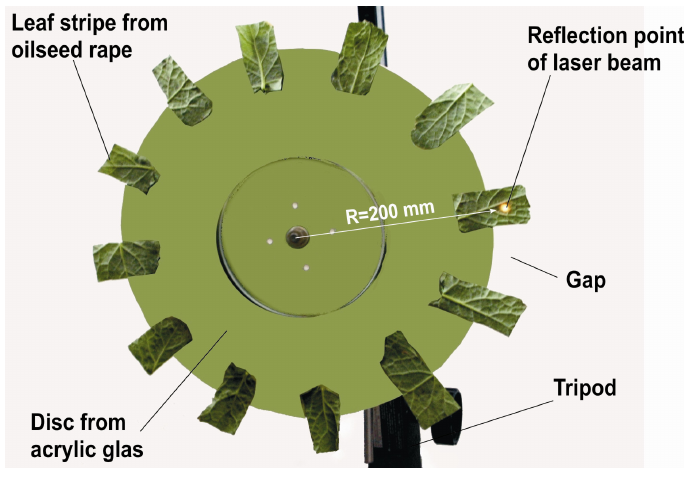
Figure 3. Rotation disc to investigate the sensor measuring properties for two reflection levels (teeth from oilseed rape and background) under dynamic